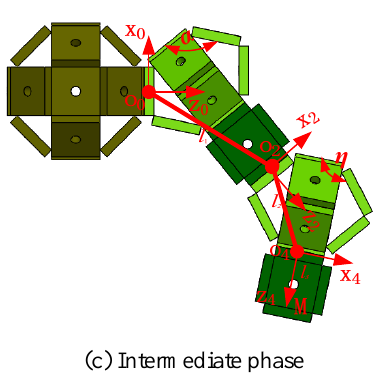
Figure 8. Geometric configurations of the bio-inspired robotic arm.